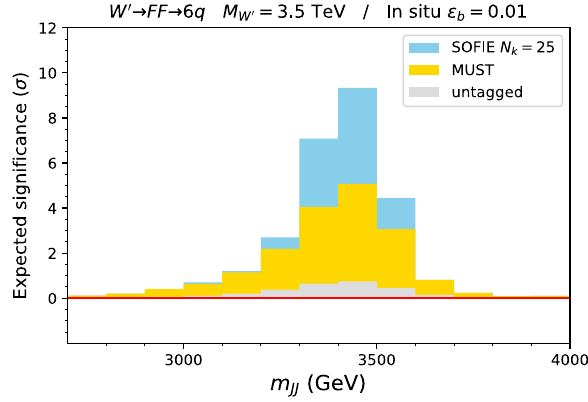
Fig. 13 Expected significance of the deviations per 100 GeV bin at three stages: a in the untagged event sample; b using only the MUST jet tagging; c using the full SOFIE anomaly detection method. In-situ mass decorrelation is used with ε b = 0 . 01